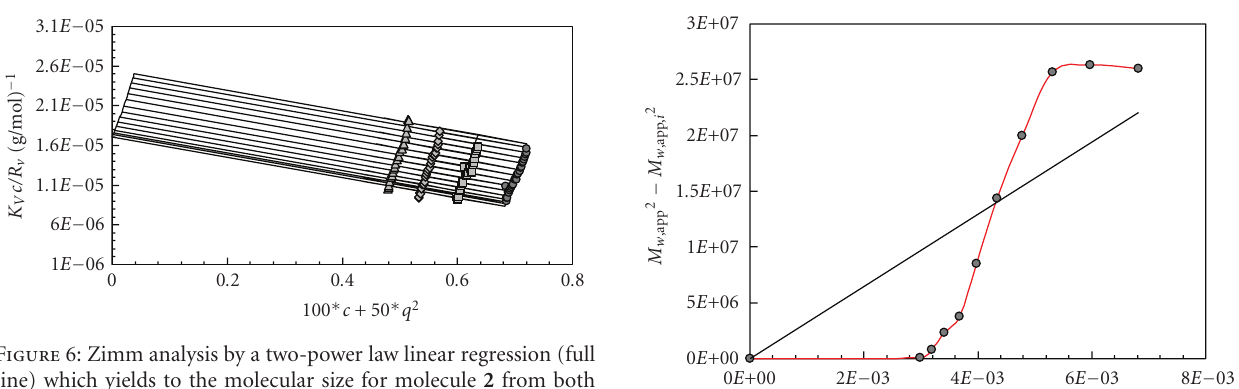
(cid:4) 1 / 2 = g Z Figure 8: Determination of K 0 for compound 2 . M w ,app, i is the molecular weight of the initial monomer starting the association [59, 60]. The red guiding line shows the experimental points’ sigmo ¨ ıdal behaviour. From the straight line, extrapolated for a noncooperative association, it is possible to calculate the mean equilibrium constant of the association K 0 = 6 . 7 10 5 Lmol − 1